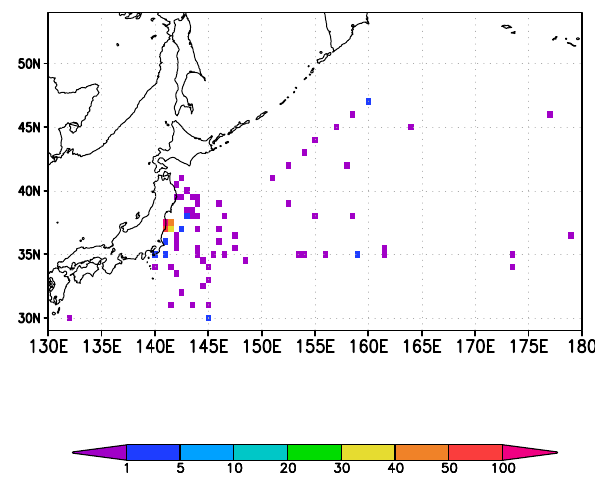
Fig. 3. Numbers of the caesium-137 ( 137 Cs) measurements within 1 ◦ × 1 ◦ grids sampled during the period from 21 March to 6 May 2011. 137 Cs transport from the source grid to the surrounding